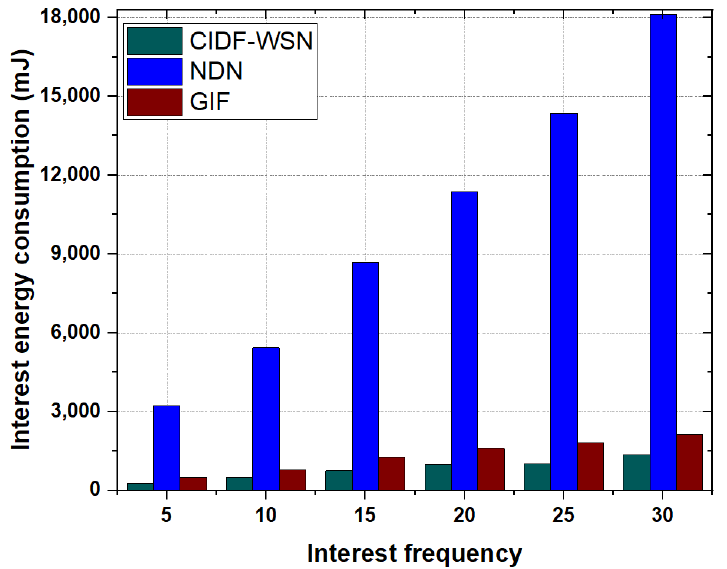
Figure 10. Interest energy consumption as a function of